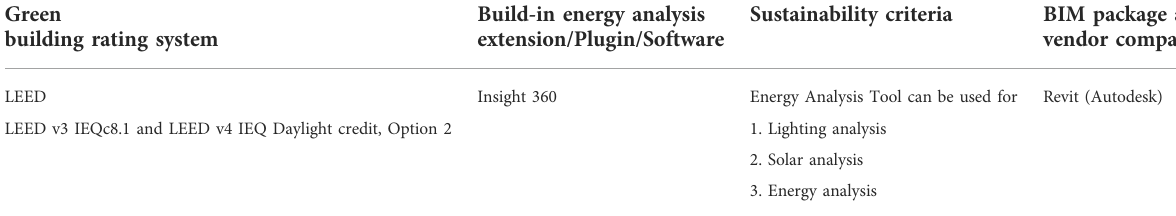
TABLE 3 A table showing the Autodesk Revit insight plug-in (5 Ways Revit Supports Green Building, 2017). Green building rating